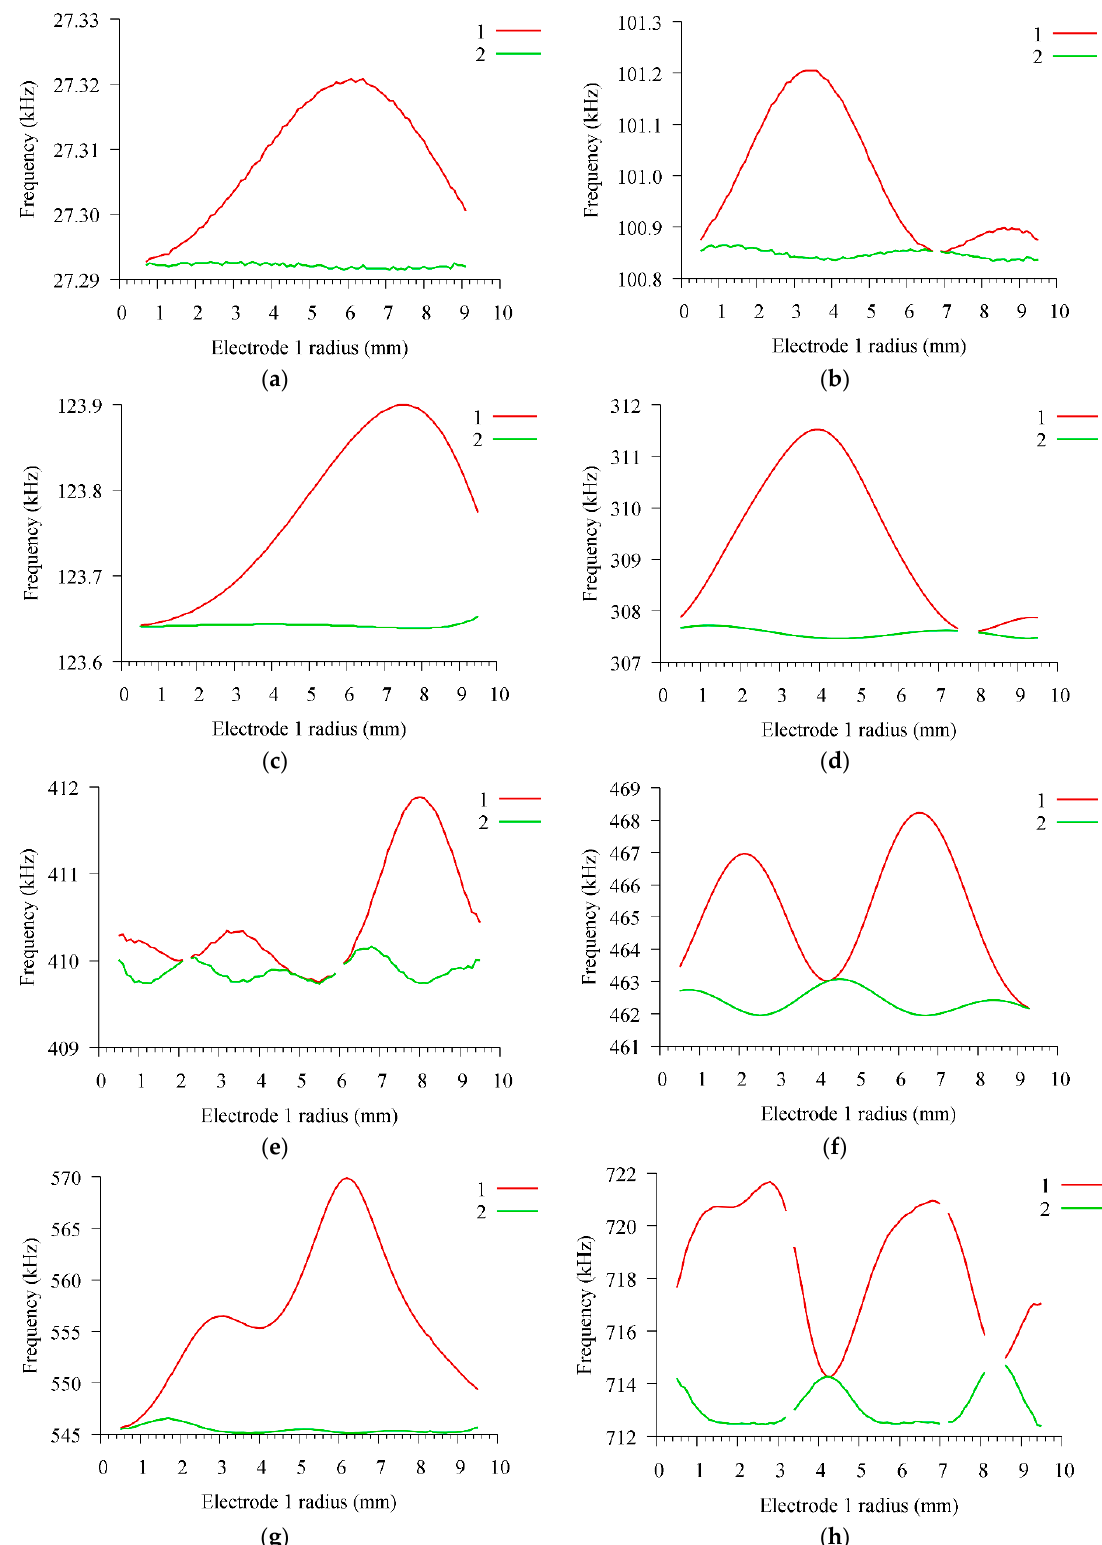
Figure 7. Dependences of the frequencies of (1) parallel and (2) series resonances on the radius of the inner electrode e 1 for modes ( a )F0, ( b ) F1, ( c ) R0, ( d ) R1, ( e ) F3, ( f ) TE0, ( g ) F5, and ( h ) TE2.